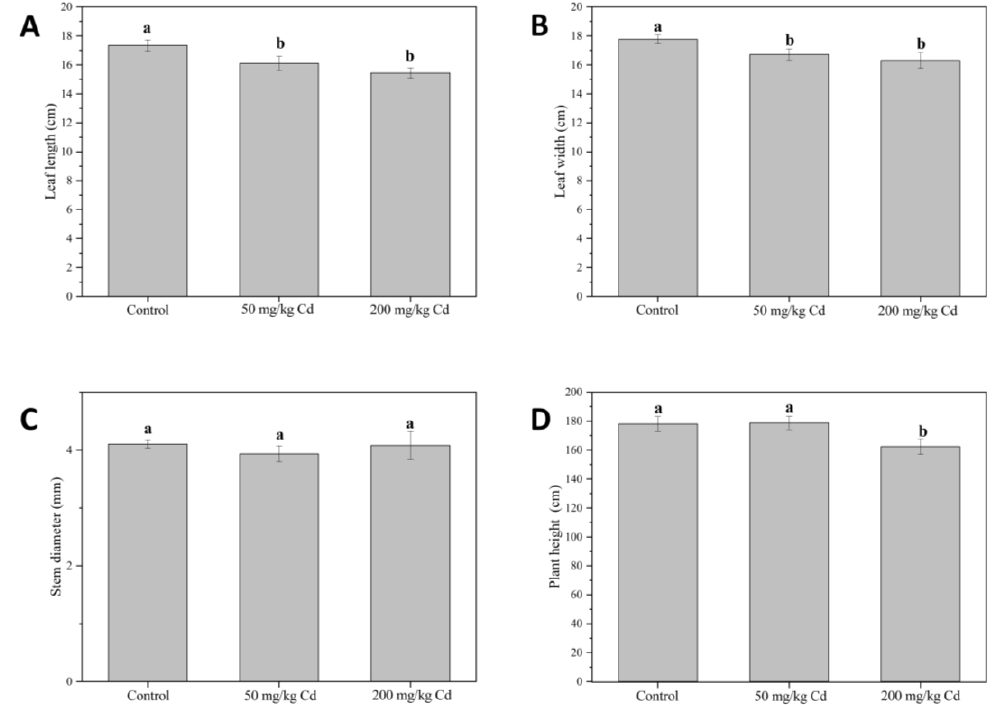
Figure 1. Leaf length ( A ), leaf width ( B ), stem diameter ( C ), and plant height ( D ) of muskmelon plants in different treatment groups. The data were three repeated means ± standard deviation. Different lowercase letters indicate significant differences at p < 0.05.